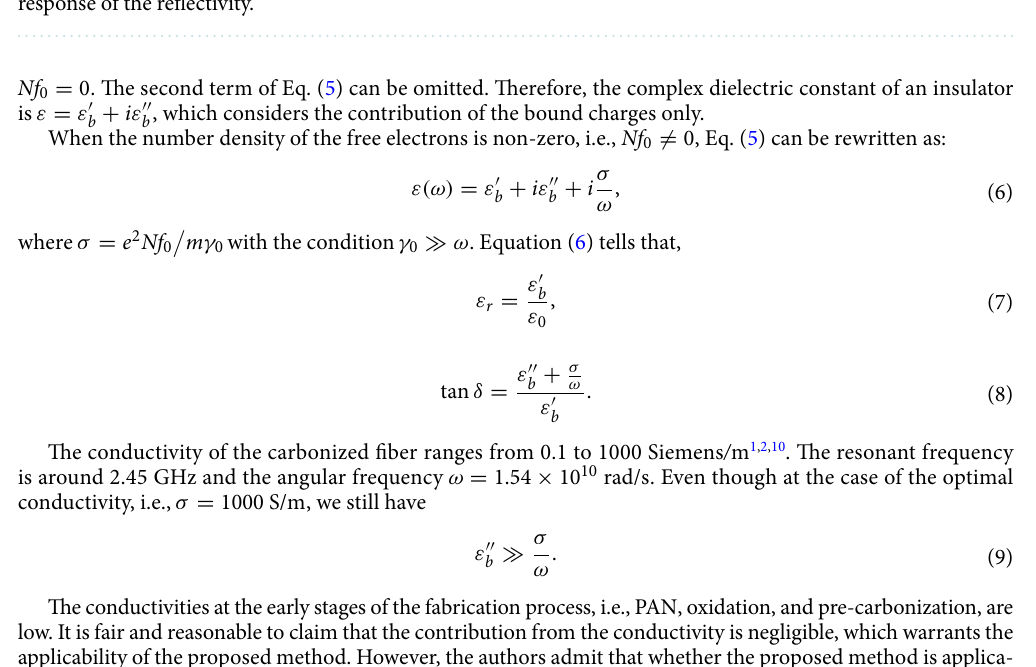
Figure 4. Experimental setup of the enhanced-field method (EFM). ( a ) The fiber is crammed randomly into a Teflon sample holder. ( b ) The sample holder is then placed in the specially designed EFM cavity at a frequency around 2.45 GHz. ( c ) The one-port system is connected to a network analyzer to measure the frequency response of the